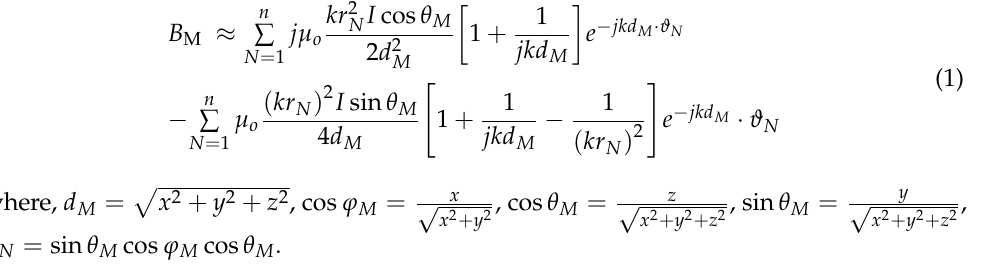
illustrated in Figure 2: neglecting the radial current segments, the two half-loops are replaced by two concentric circular coils with the same current but opposite phase. The inner radius and outer radius of the two concentric circular coils are consistent with Figure 1. In Figure 2, the geometric model of the distance from the center of coil to point M is demonstrated, where the magnetic flux density at point M is a function of the coil radius, the current flowing through the coil, and the distance from the coil center to point M. The total magnetic flux density at point M is calculated by the following Equation (1)